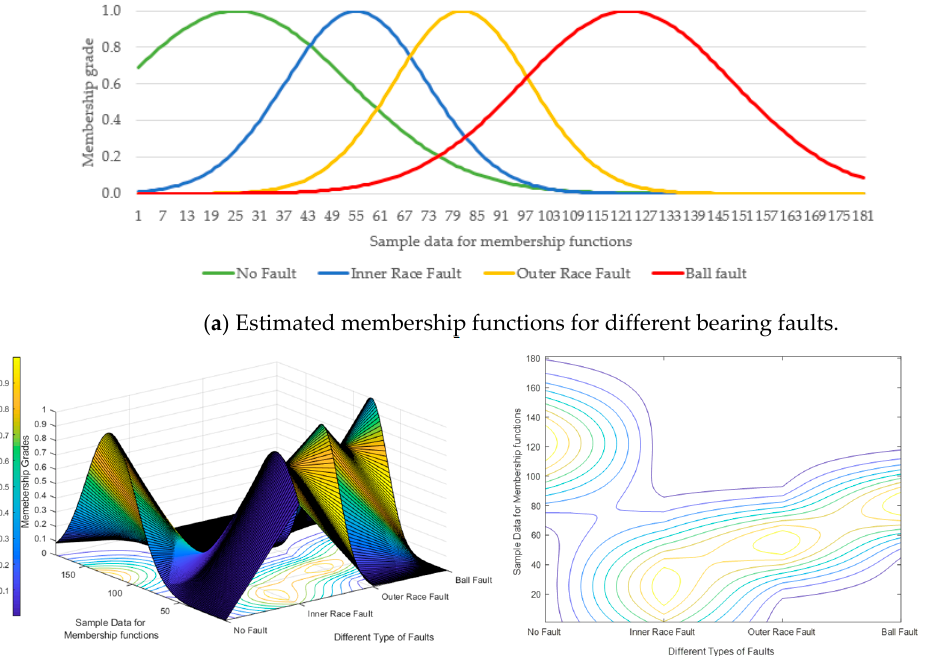
Figure 9. Estimated membership functions of the experimental data for different bearing faults.